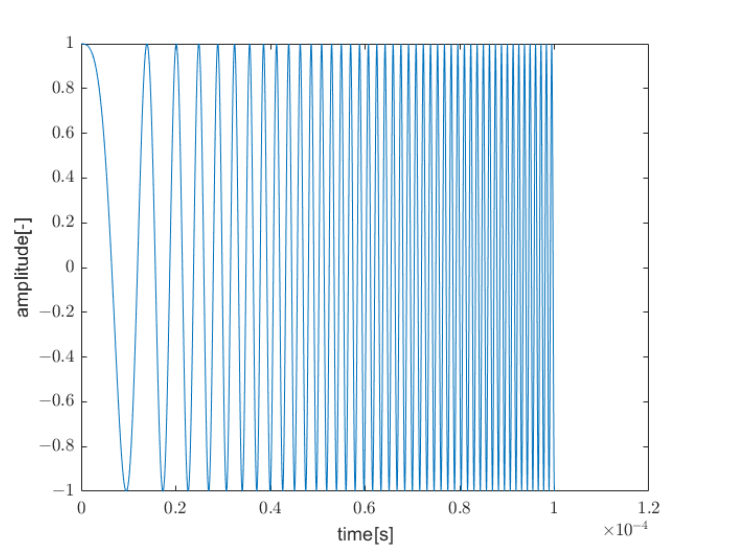
Figure 2. An example of a frequency-modulated signal called chirp. This type of sampling signal is commonly used in high-precision sonars. The different frequency at each point of the pulse provides high distance resolution and low susceptibility to